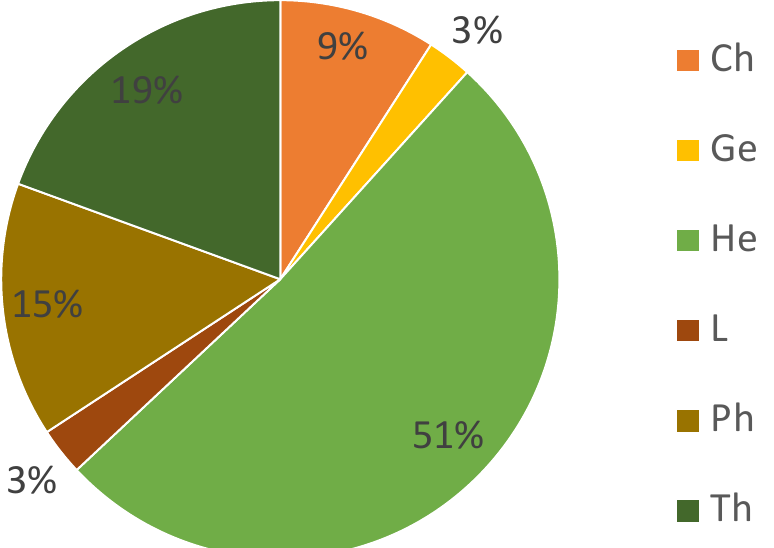
Figure 4. Average percentage of each life form in the studied mosaic of habitats at the former mine site. Ph: Phanerophytes; He: Hemicryptophytes; Ch: Chamaephytes; L: Liana; Ge: Geophytes; Th: Therophytes.